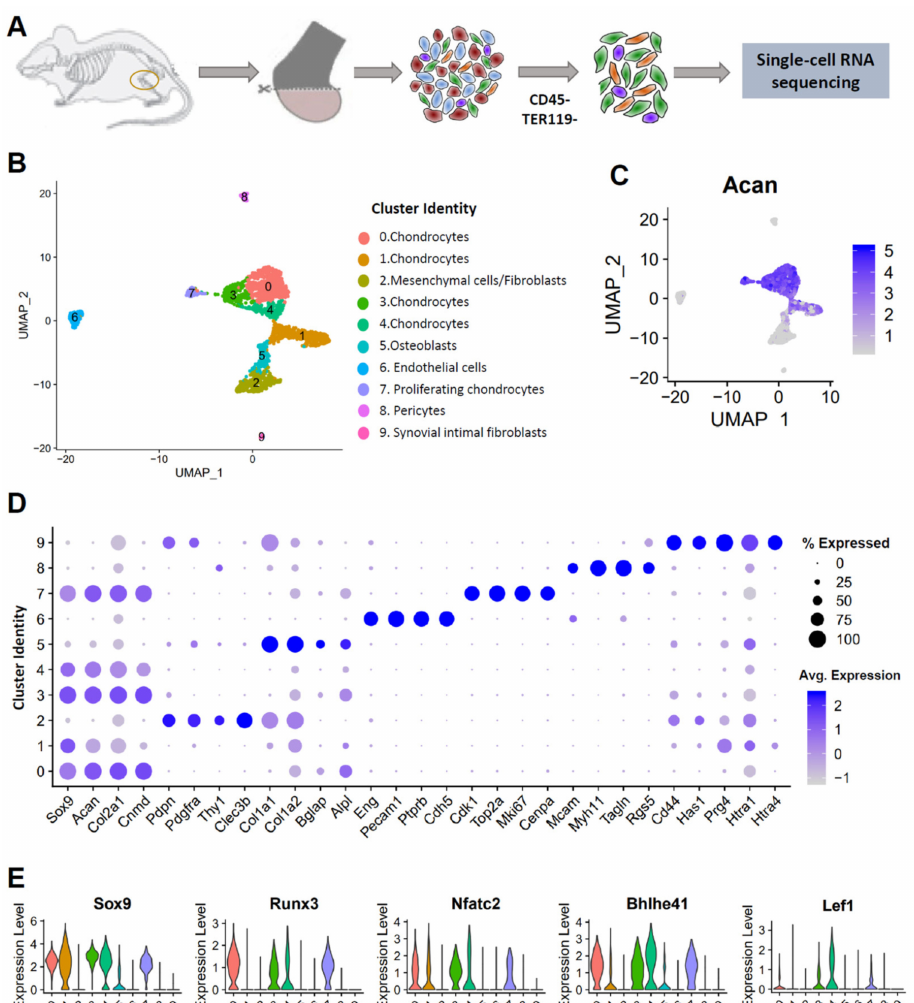
Figure 1. Single-cell analysis of 10-week-old BL6 mouse knee joints. ( A ) Graphical representation of the experimental workflow. Cartilage from mouse knee joints was dissected, dissociated into single cells, and subjected to immune and blood cell depletion. Viable cells from the remaining fraction were sequenced. ( B ) Cell clusters from scRNA-seq analysis visualized by Uniform Manifold Approximation and Projection (UMAP). Colors indicate clusters of various cell types. ( C ) Feature plot showing the expression of chondrocyte marker Acan . ( D ) Dot plot showing the expression of selected markers of various cell types. Dot size represents the % of cells expressing a specific marker, while the intensity of color indicates the average expression level for that gene, in that cluster. ( E ) Violin plot showing the expression of key transcription factors enriched in